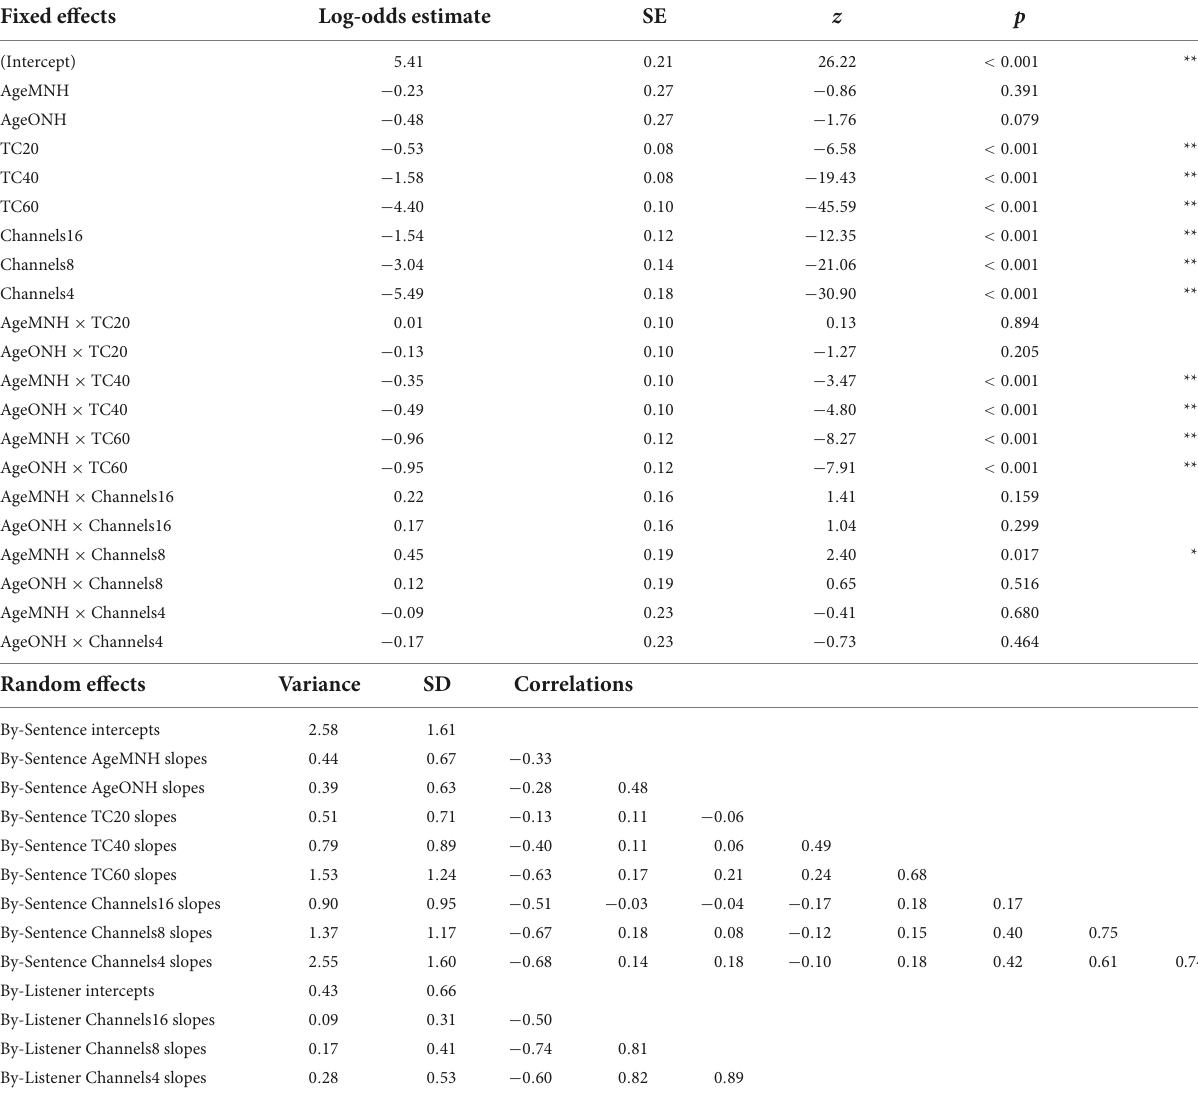
TABLE 2 Logistic mixed-effects model describing the effects of experimental variables and other predictors on speech recognition performance of listeners with NH. Fixed